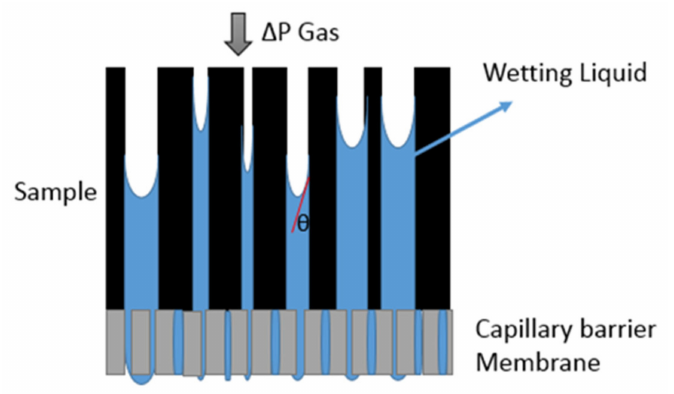
Figure 3. Principles of liquid extrusion porometry